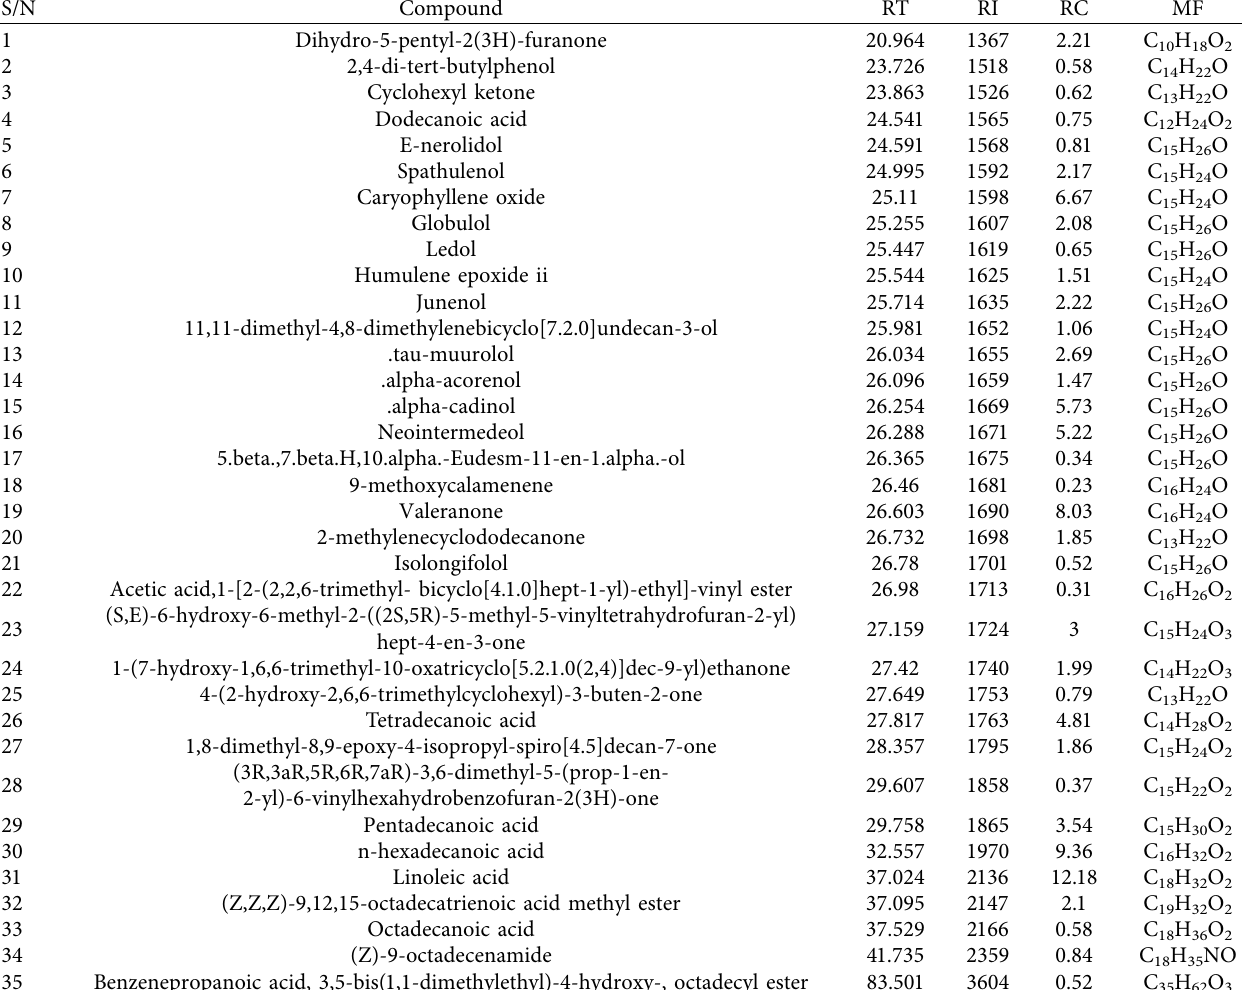
Table 2: Compound detected in the GC-MS analysis of the essential oil from dried S. rugosoannulata fruiting bodies. S/N Compound